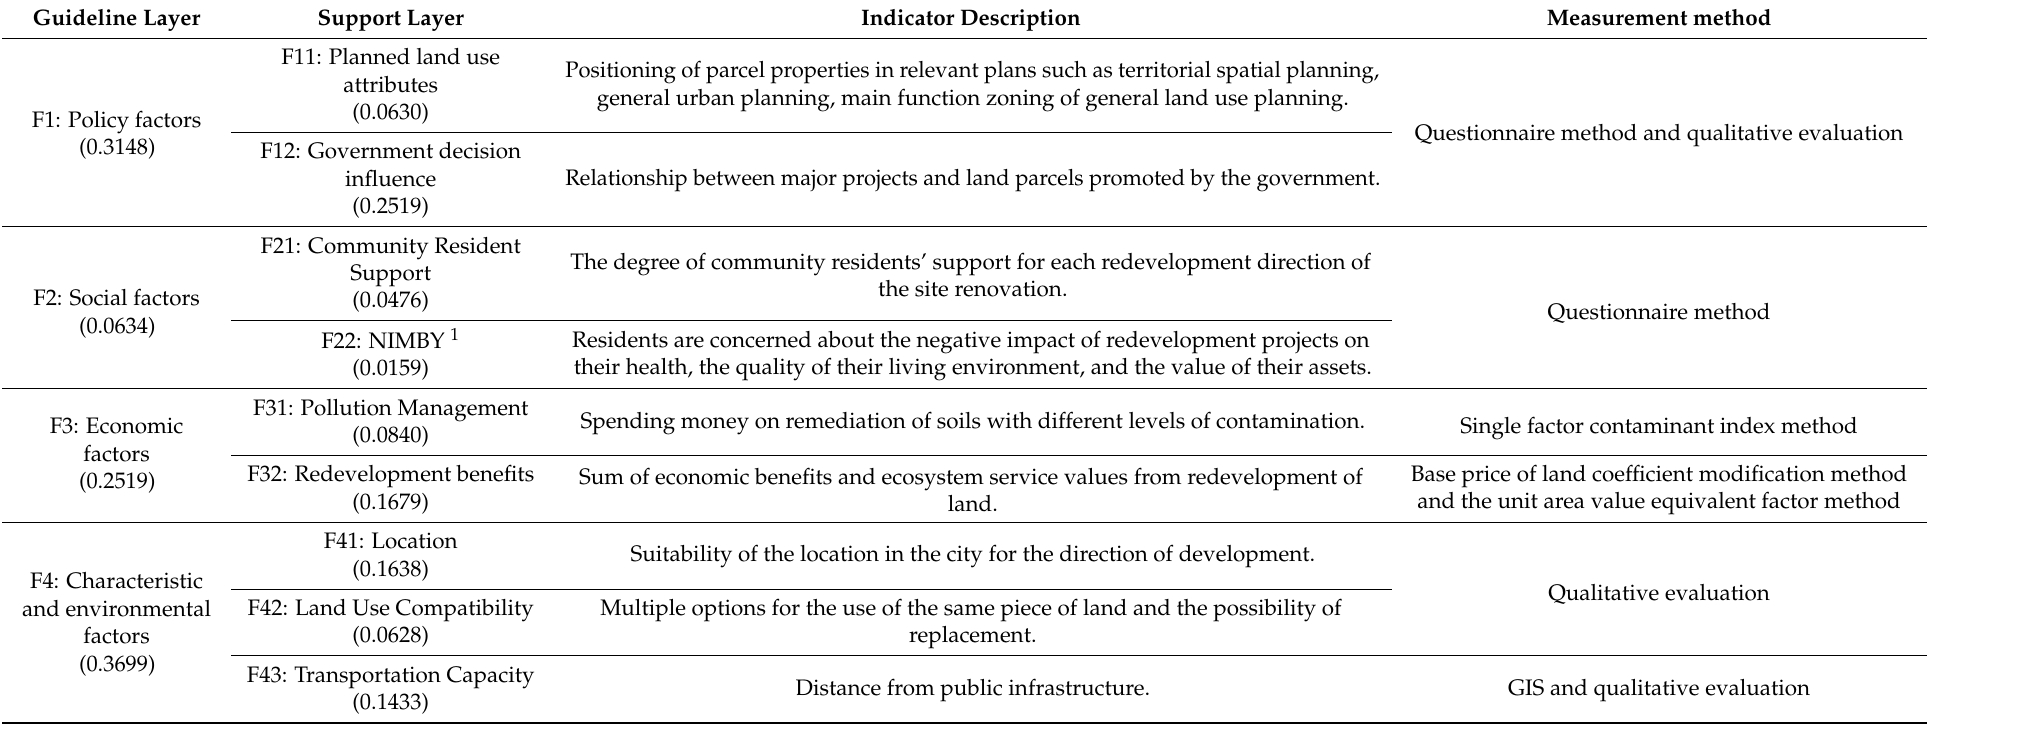
Table 1. Screening values and control values for the risk of heavy metal contamination of soil on construction